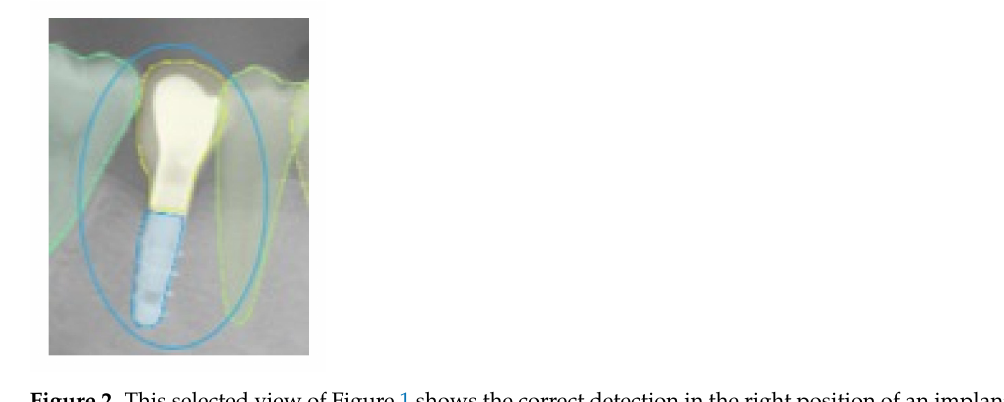
Figure 2. This selected view of Figure 1 shows the correct detection in the right position of an implant. The assigned value was TP.